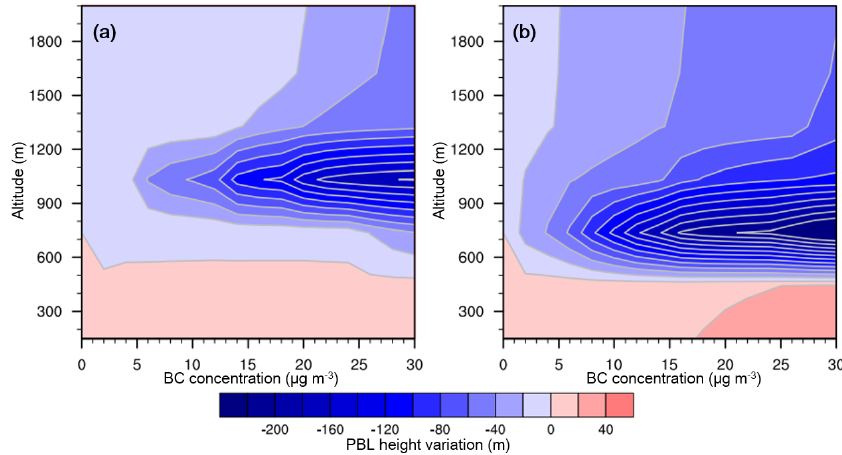
Figure 9. Different PBL height variations due to specific BC distribution over (a) urban surface and (b) rural land surface. The x and y axes are the same as Fig.